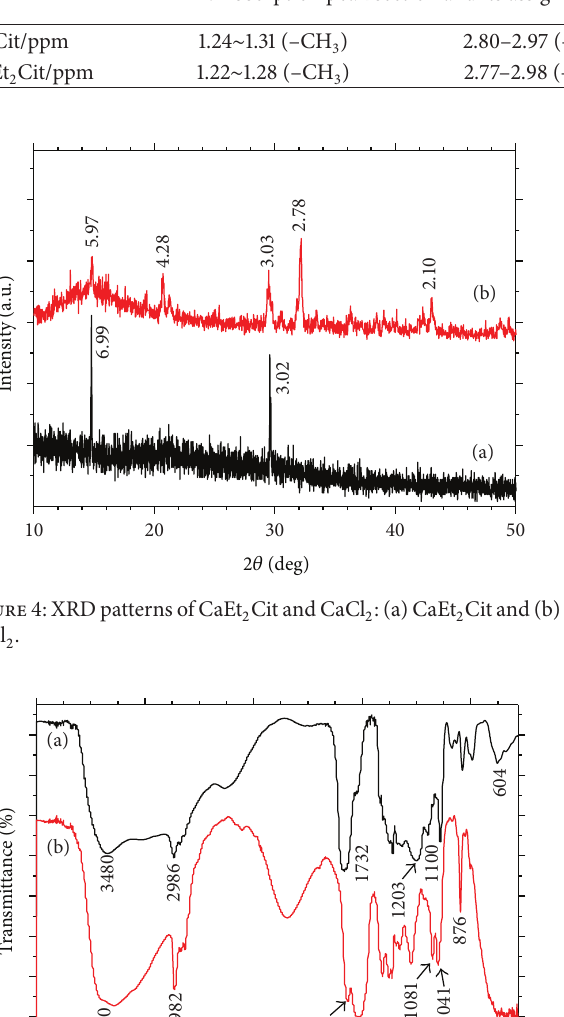
Table 4: Absorption peak section and its assignment of the 1 H NMR spectra of Et